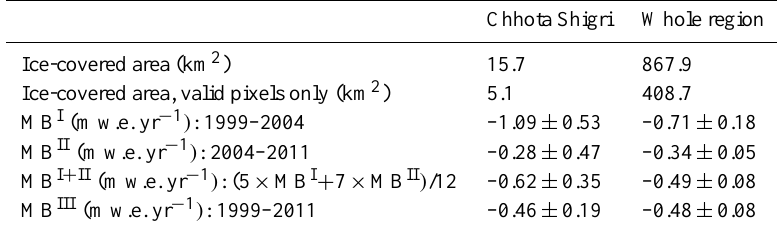
Table 6. Same as Table 4 but using only pixels that are valid in all three DEMs to avoid the sampling issues described in Sect. 3.2.2. This table is only provided to show how a different sampling can explain the differences between MB I + II and MB III . However, MB values in Table 4 should be preferred because they are based on the best coverage of glaciers.